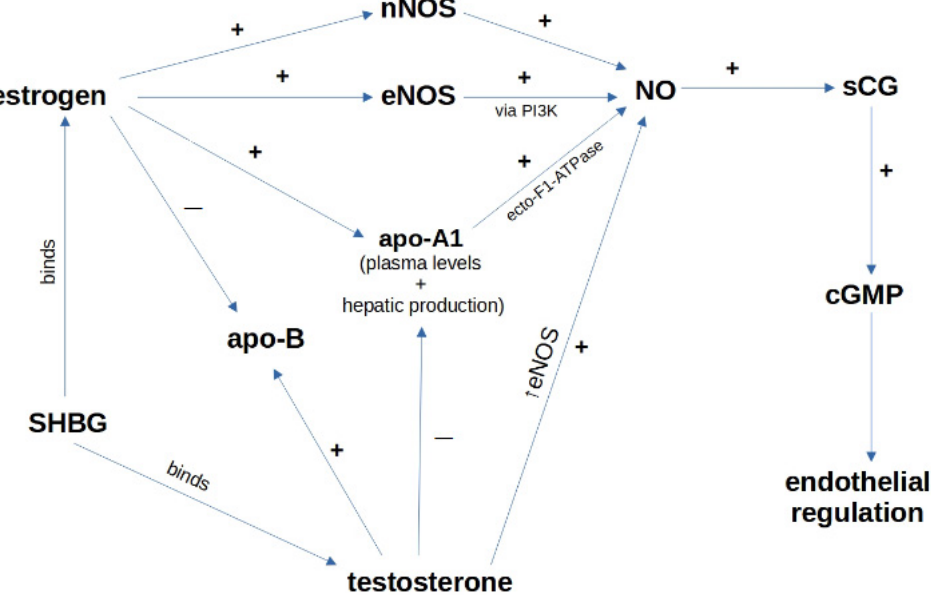
Figure 2. Effect of testosterone on endothelial activity of different Figure 2. E ff ect of testosterone on endothelial activity of di ff erent molecules. Estrogen has been known for inducing vasodilation in the cardiovascular system by increasing NO production through multiple pathways: increasing endothelial and neu- ronal nitric oxide synthase (respectively, eNOS and nNOS), and raising serum concentra- tion of Apo-A1. Endothelial NO production is conclusively promoted by Apo-A1 and thereby controls vascular tone in a process that requires activation of the ecto-F1- ATPase/P2Y1. Testosterone induces enhancement of NO signaling via increased eNOS ex- pression, but diminishes levels of Apo-A1 (reversely to estrogen). In human blood, be- tween 40 and 65% of circulating testosterone and between 20 and 40% of circulating estra- diol is bound to SHBG. Binding to SHBG also prevents bound hormones sfrom di ff using out of the bloodstream, thereby preventing hormones binding to the intracellular andro- gen or estrogen receptors [21].